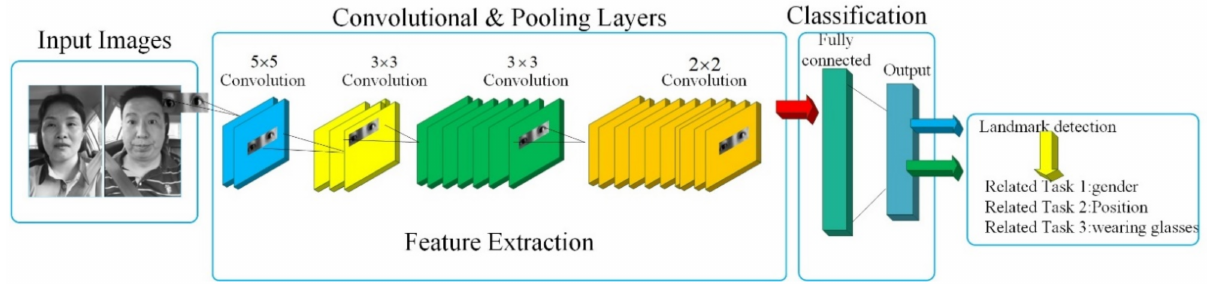
Figure 2. The architecture of